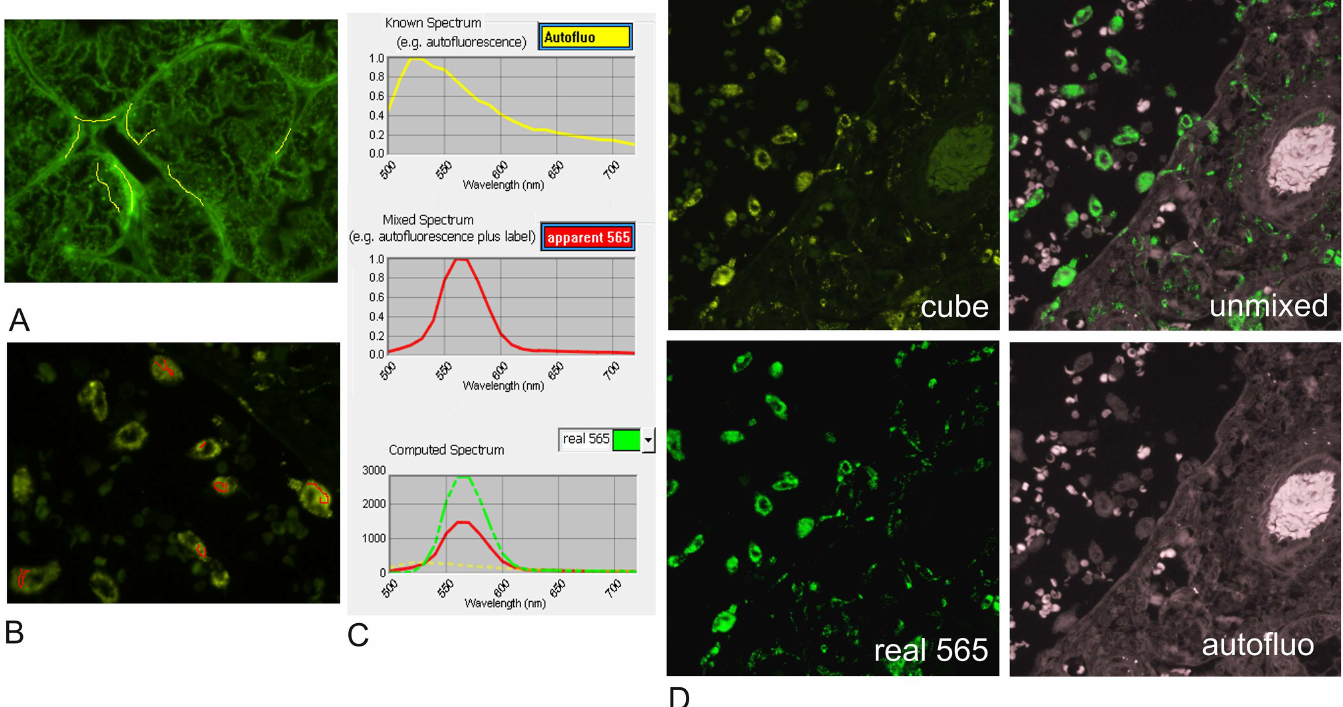
Fig 1. Exampleof spectralunmixing usingNuance[12,13]. FFPE tissue sectionsare imagedat single wavelengths every 10nmfrom500nm to 720nm (an image “cube”).Unstainedand single color stainedcontrolsectionsestablish the specific emissionspectrumof each color of interestand the auto- fluorescence spectrum(Fig 1A–1C).Those spectra are used to “unmix”grey-scale imagesfromthe cube datasetcorresponding to the trueintensityof fluorescence of each color of interestand separately the background autofluorescence in the test section. A) shows tissueautofluorescence whose spectrumin the regions underthe yellow drawn lines on the image is depictedin the adjacentyellow spectrumplot. B) Similarly shows single colourstaining for Qdot565and the associatedspectrum(red drawn lines and plot),which is a compound of fluorophorewith autofluorescence. In C), the autofluorescence contribution to the stainingspectrumfor Qdot565shown in B has been subtractedin Nuance, giving the actual specific stainingintensityfor the fluorophore. D) shows trueintensityimagescomputed in this way fromthe parentcube data,discriminating autofluorescence and colour markercomponents for each pixel, which can be viewed and quantifiedindividually. Each fluorescence imagesare scaled using the Clip/Stretch option withinNuance mappingthe lowest 0.01%of the pixels to 0, the highest0.01% to 255, with linearlyinterpolation in between those values for visualisation.